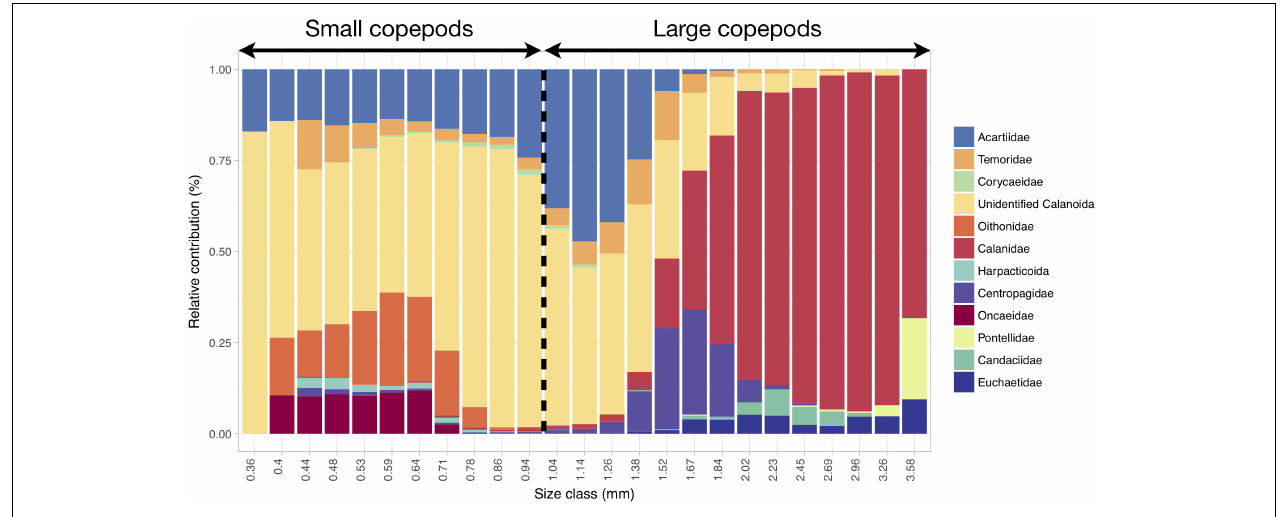
FIGURE 6 | Relative contribution (in % of abundance) of the copepod categories to the size spectrum showing that progressive changes in size correspond to changes in taxonomic composition. The range and categories of the size spectrum were defined based on all copepod images together, and the relative contributions were computed from all samples. The 1 mm threshold chosen for distinguishing small from large copepods is highlighted. Copepod size was estimated through the length of the major axis of the corresponding